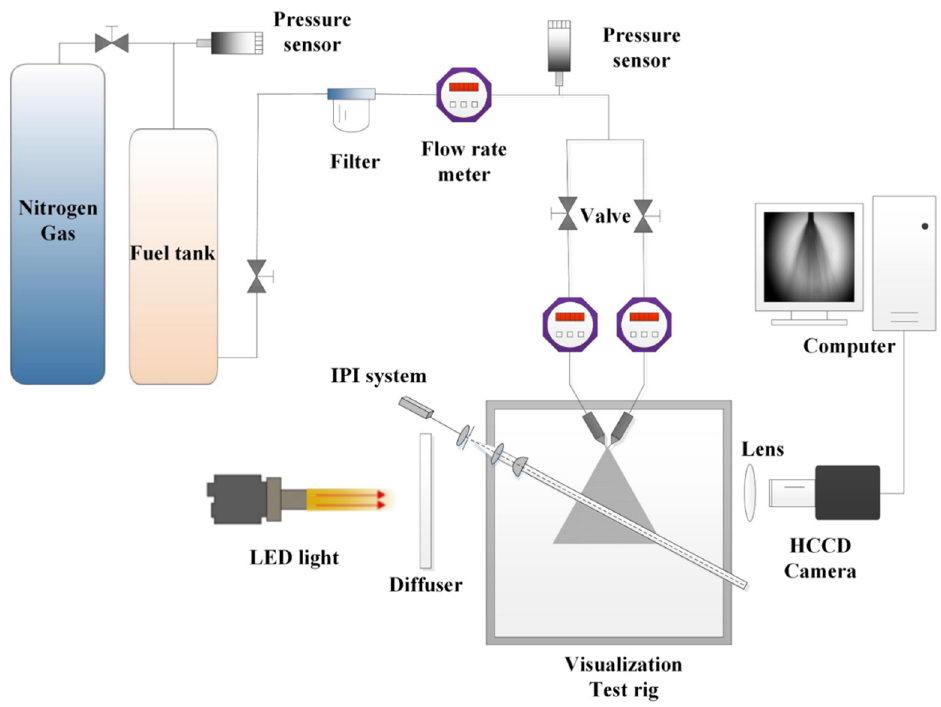
Figure 7. Schematic diagram of the whole device of the visualization experimental system for the internal flow field of the impinging nozzle (Figure adapted from [7]).